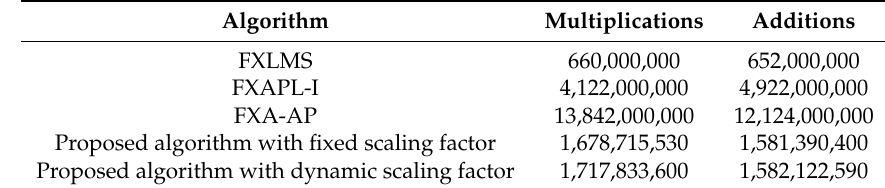
Figure 4. Learning curves for the FXAPL-I algorithm, the FXLMS algorithm, the FXA-AP algorithm and the proposed algorithm for a Gaussian noise input in a single-channel system. Table 9. Total number of multiplications and additions of the FXAPL-I, FXLMS, FXA-AP and the proposed algorithms for a single-channel ANC system using a Gaussian noise